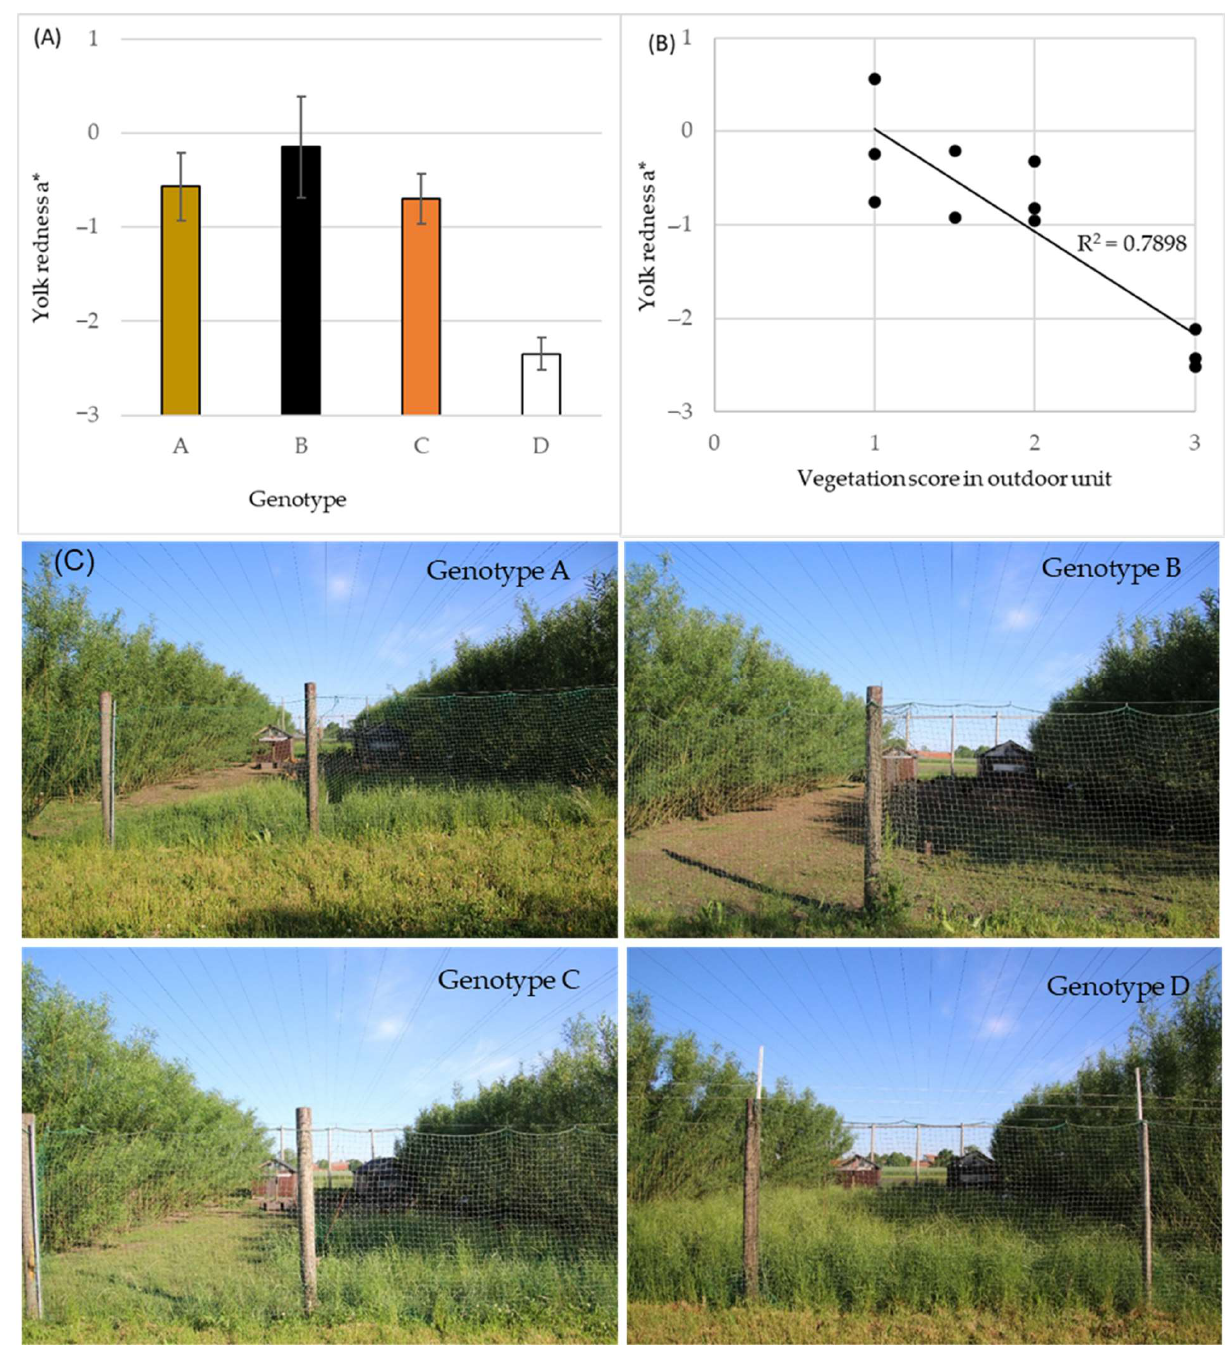
Figure 4 . The correct legend and corrected Figure 4 appear below.